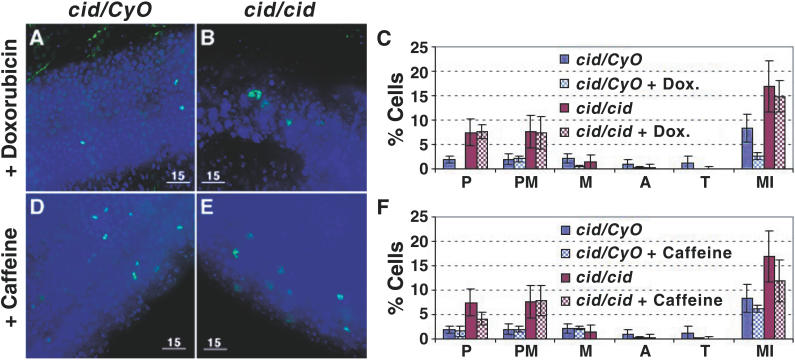
DNA Damage Is Not Responsible for the cid-Mediated Mitotic DelayThe effect of DNA damage on cell cycle progression was determined by treating stage 15 cid null and heterozygous embryos with the topoisomerase II inhibitor doxorubicin.(A–C) cid/CyO cells dramatically decreased entry into mitosis in response to DNA damage, whereas cid/cid cells were unaffected by doxorubicin (Dox.) treatment.(D–F) The MEI-41/ATR kinase was inhibited by treating cid homozygous and heterozygous embryos with 2 mM caffeine. Inactivation of the DNA damage checkpoint did not suppress the cid-mediated mitotic delay, as the mitotic index of cid mutants remained double that of controls, with the majority of the mitotic cells delayed in prophase or prometaphase.A, anaphase; M, metaphase; MI, mitotic index; P, prophase; PM, prometaphase; T, telophase.Scale bars indicate 15 μm.